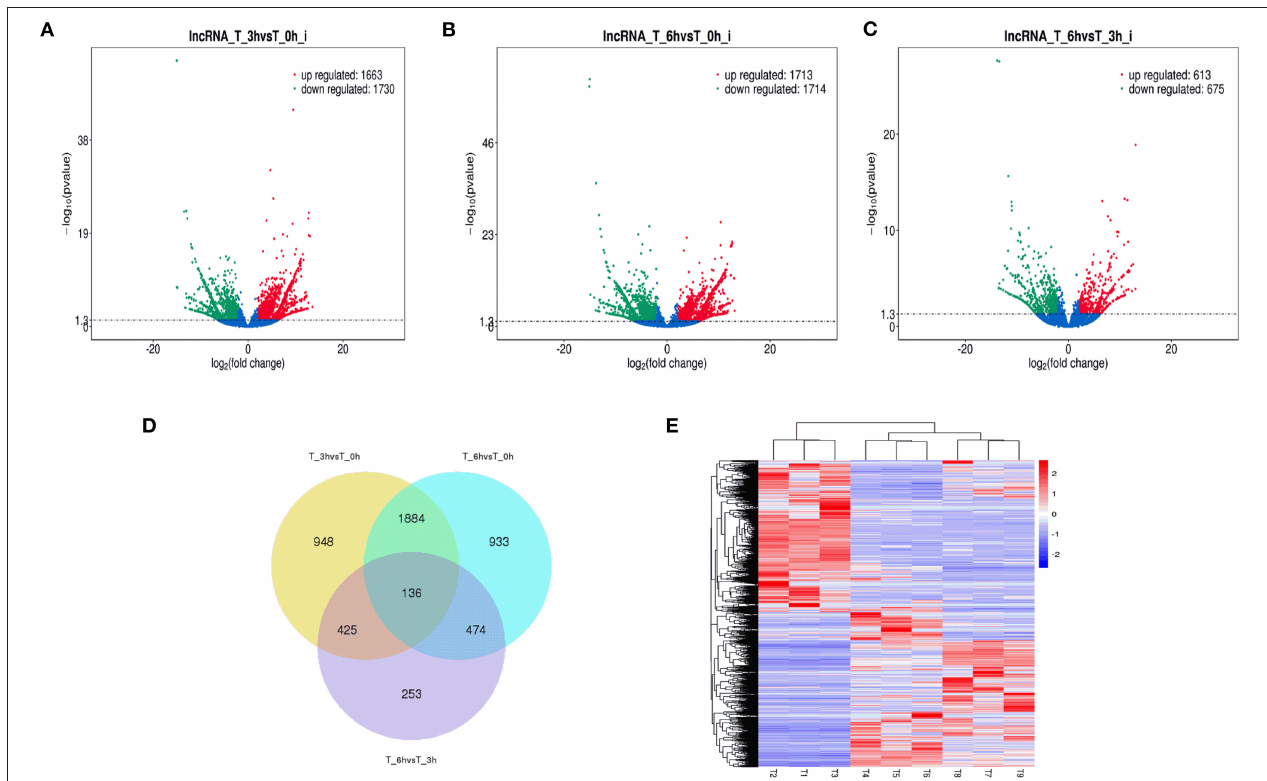
FIGURE 3 | Changes in miRNA expression during SE infection in duck granulosa cells. (A–C) Volcano plots showing up- and down-regulated miRNAs of 3 vs. 0, 6 vs. 0, and 6 vs. 3 hpi group, respectively. (D) Venn diagram showing the number of overlapping differentially expressed miRNA between 0, 3, and 6 hpi. (E) Heat map of miRNAs showing hierarchical clustering of DE-mRNAs between 0, 3, and 6 hpi. Up- and down-regulated miRNAs are shown in red and blue, respectively.